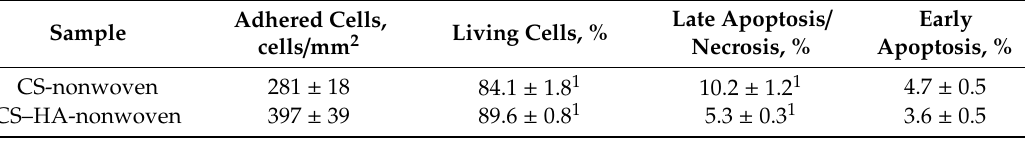
Figure 5. Representative cell morphology after three days of co-cultivation of mesenchymal stem cells (MSC) and cover glass (first row), CS scaffold (second row), and CS – HA scaffold (third row) and after six days of co-cultivation with CS – HA scaffold (fourth row). Table 4. Biocompatibility testing results after three days of MSC and scaffold co-cultivation, mean ± standard error (n ≥3) . Table 4. Biocompatibility testing results after three days of MSC and sca ff old co-cultivation, mean ± standard error (n ≥ 3).